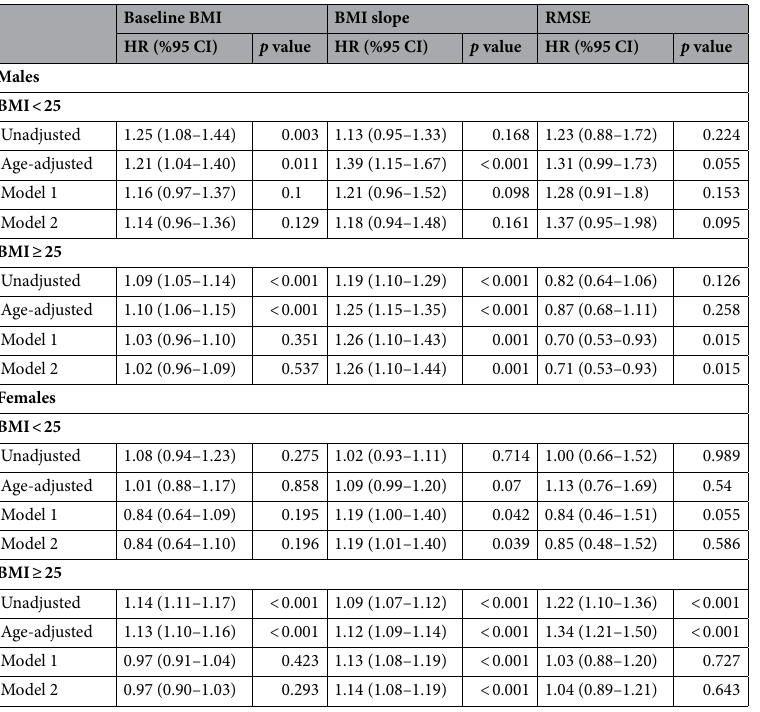
Table 3. Sex- and BMI-stratified hazard ratios of type 2 diabetes mellitus. Model 1 is adjusted for age, baseline BMI, BMI slope, and BMI-RMSE. Model 2 is adjusted for model 1, as well as family history of diabetes, education level and smoking. RMSE root mean squared error, HR hazard ratio, CI confidence